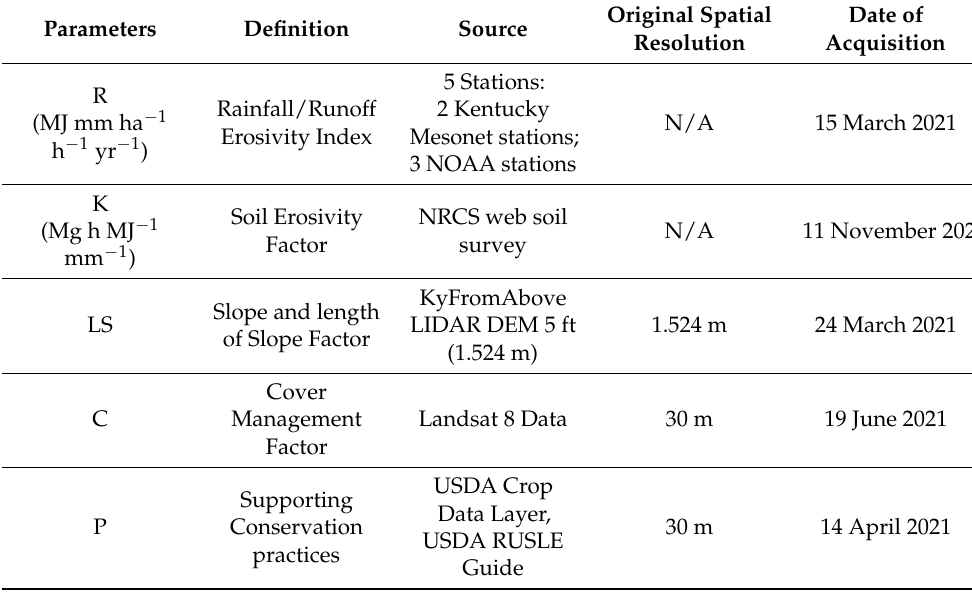
Table 2. List of Parameters for Universal Soil Loss Equation with their data sources.